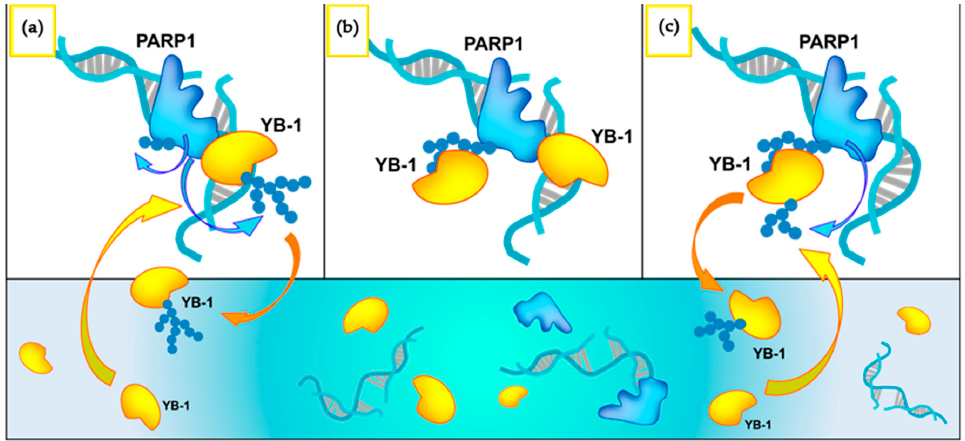
Figure 12. A simplified model of YB-1-dependent mechanisms of PARP1 activity regulation . ( a ) Formation of the heteromeric complex of PARP1–YB-1 with damaged DNA. In the ternary complex, YB-1 is a preferable PAR acceptor, but auto-modification of PARP1 occurs too. ( b ) Formation of the complex of YB-1 with PAR covalently attached to PARP1. As soon as the PAR chains on PARP1 reach a certain length, predominant formation of YB-1–PAR rather than YB-1–DNA–PARP1 complexes takes place. ( c ) Upon binding to PAR, YB-1 promotes the formation of shortened PAR during PARP1 auto-PARylation. YB-1 non-covalently binds to PAR chains of auto-PARylated PARP1 and relocates into spatial proximity of the catalytic centre of PARP1. Modified YB-1 molecules dissociate from the complexes, and new unmodified YB-1 molecules bind to the PAR molecule on PARP1. In conclusion, we can hypothesise that the regulation of PARP1 activity by PAR acceptor proteins may change both the extent of PARP1 autoPARylation and the overall protein PARylation level. YB-1, while being PARylated, rapidly dissociates from complexes with PARylated PARP1 (or DNA), and the next YB-1 molecule interacting with PAR (or DNA) initiates the next round of PARylation. The dissociation of PARylated YB-1 from its complexes with activated PARP1 and damaged DNA and subsequent association of the next YB-1 molecule strongly facilitate the reaction turnover. It increases the level of protein PARylation and PAR synthesis. We suppose that this model can be generalized to explain the stimulation of PARP activity by some protein factors cooperating with PARPs [34,35].